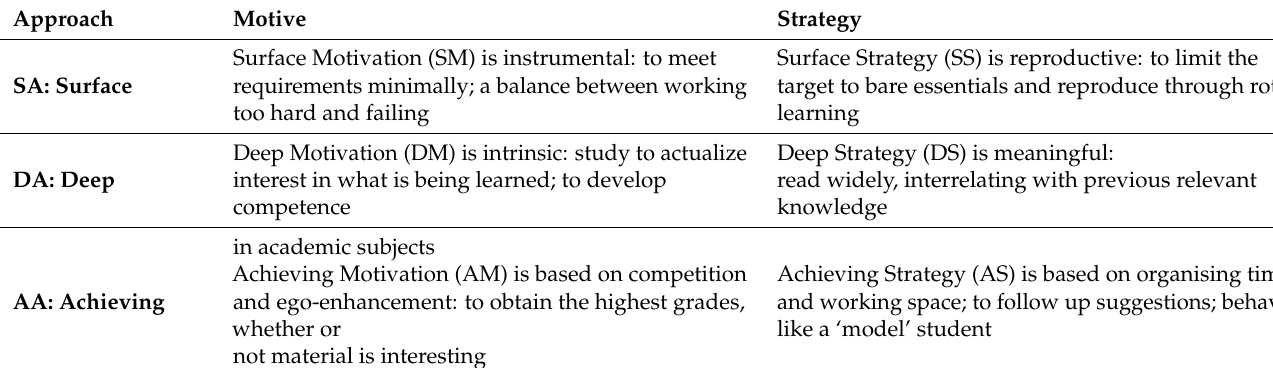
Table 2. Motivations and strategies in student approaches to